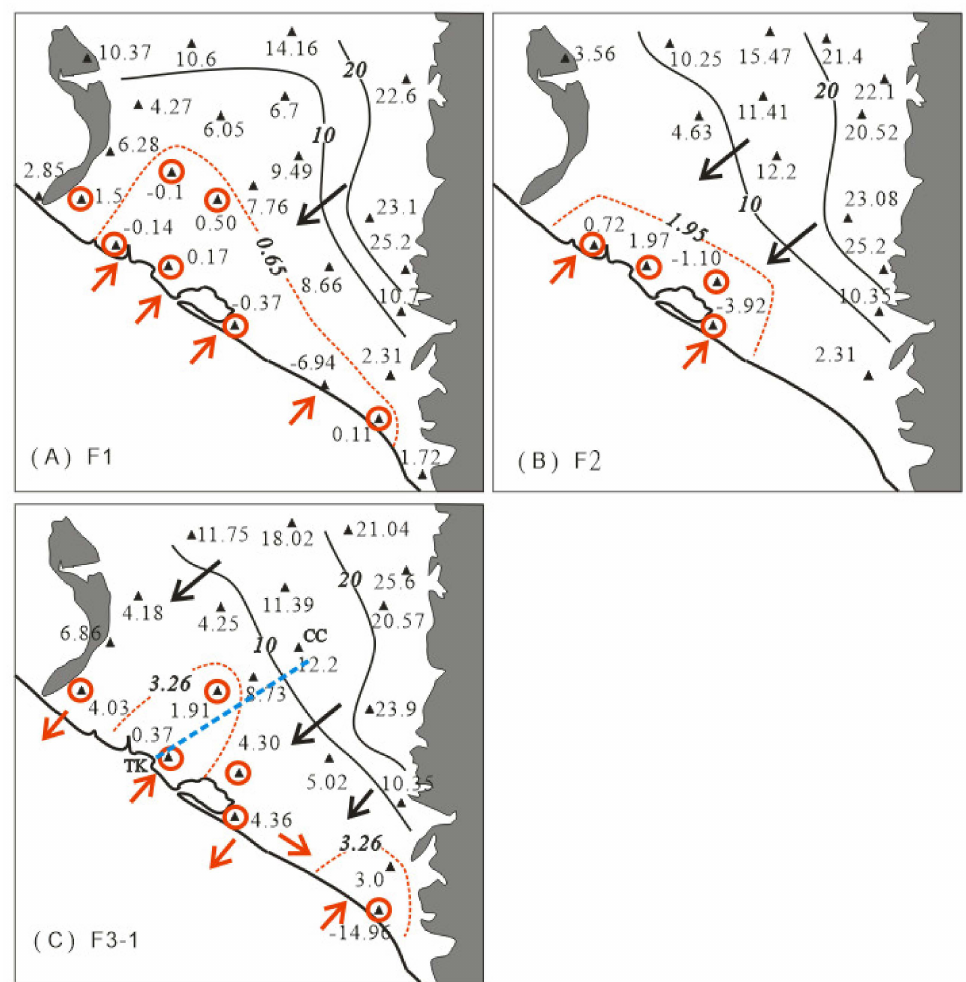
Figure 8. ( A ) The freshwater heads and flow directions of groundwater for the four aquifers within the Pingtung Plain during 2012. ( A ) The depth of aquifer F1 ranges from 0 to 50 m below the land surface, with an average depth of 25 m. The fresh head is 0.65 m, with an average depth of 25 m of seawater. The area marked by a red dashed line represents a potential seawater intrusion area in which freshwater heads were <0.65 m. ( B ) Aquifer F2 is 50–100 m in depth, with an average of 75 m. The freshwater head for 75 m seawater depth is 1.95 m. ( C ) Aquifer F3-1 is 100–150 m in depth, with an average of 125